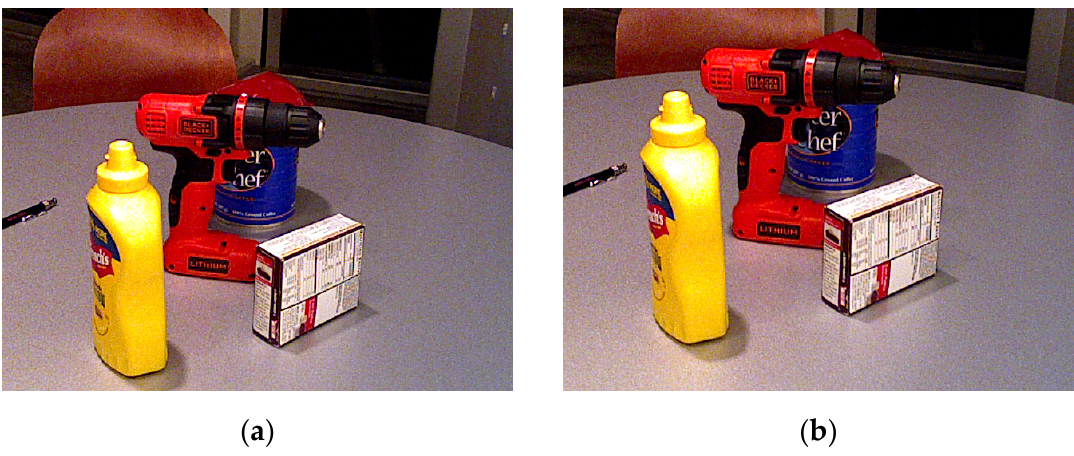
Figure 12. Test images in the YCB 0024 dataset. ( a ) 000001-color; ( b ) 000050-color. Table 1. Test results of the YCB 0024 dataset.